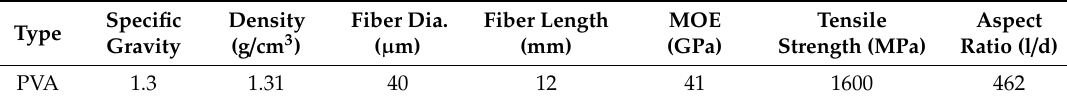
Table 2. Properties of polyvinyl alcohol (PVA) fiber [57].